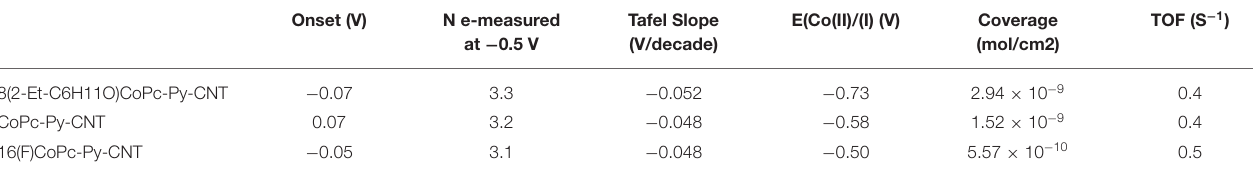
TABLE 3 | Summary of the electrochemical results obtained for 8(2-Et-C 6 H 11 O)CoPc-Py-CNT (Blue), CoPc-Py-CNT (Black), and 16(F)CoPc-Py-CNT.